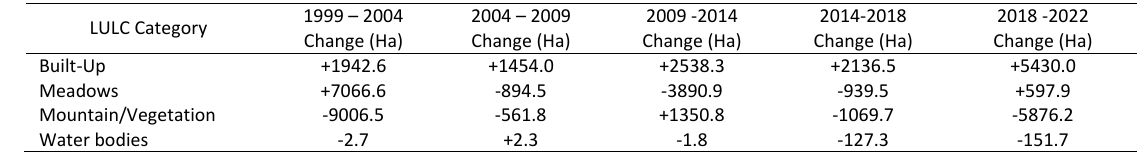
Table 5: LULC change detection from 1999 to 2022